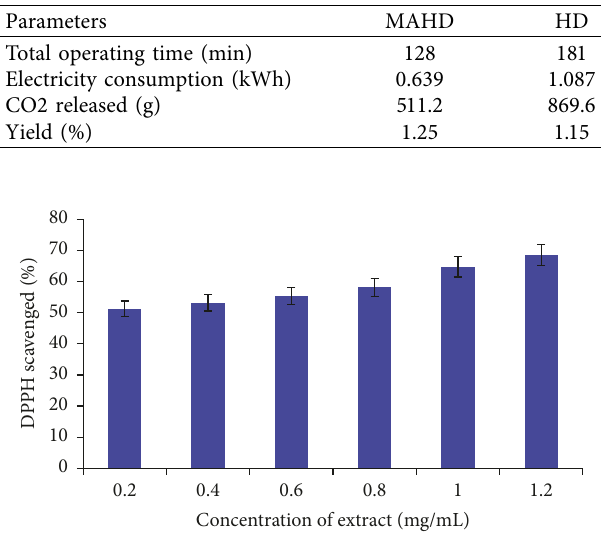
Figure 4: DPPH radical scavenging activity of essential oil and the methanol extract of hibiscus flower and the IC 50 of essential oil 0.7